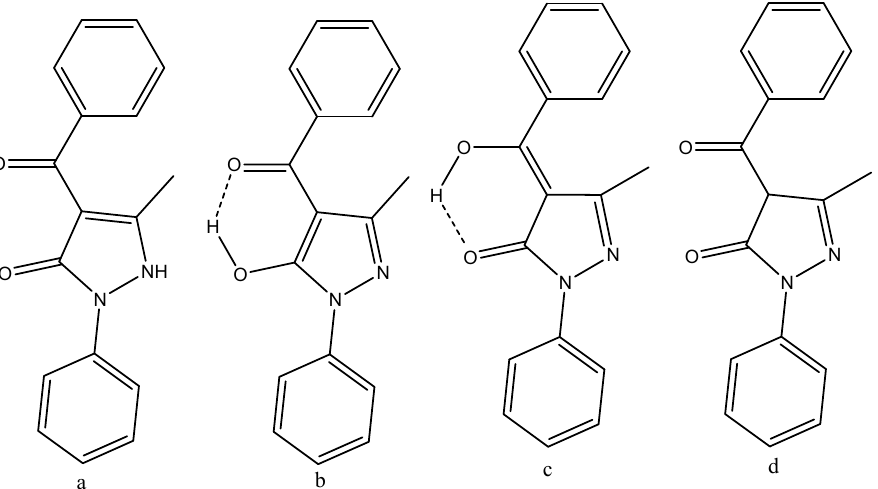
Figure 8. Tautomeric forms, ( a , d ) are ditketo forms, ( b , c ) are enol forms of 4-benzoyl-3-methyl-1-phenylpyrazol-5-one (HQPh). From [44].